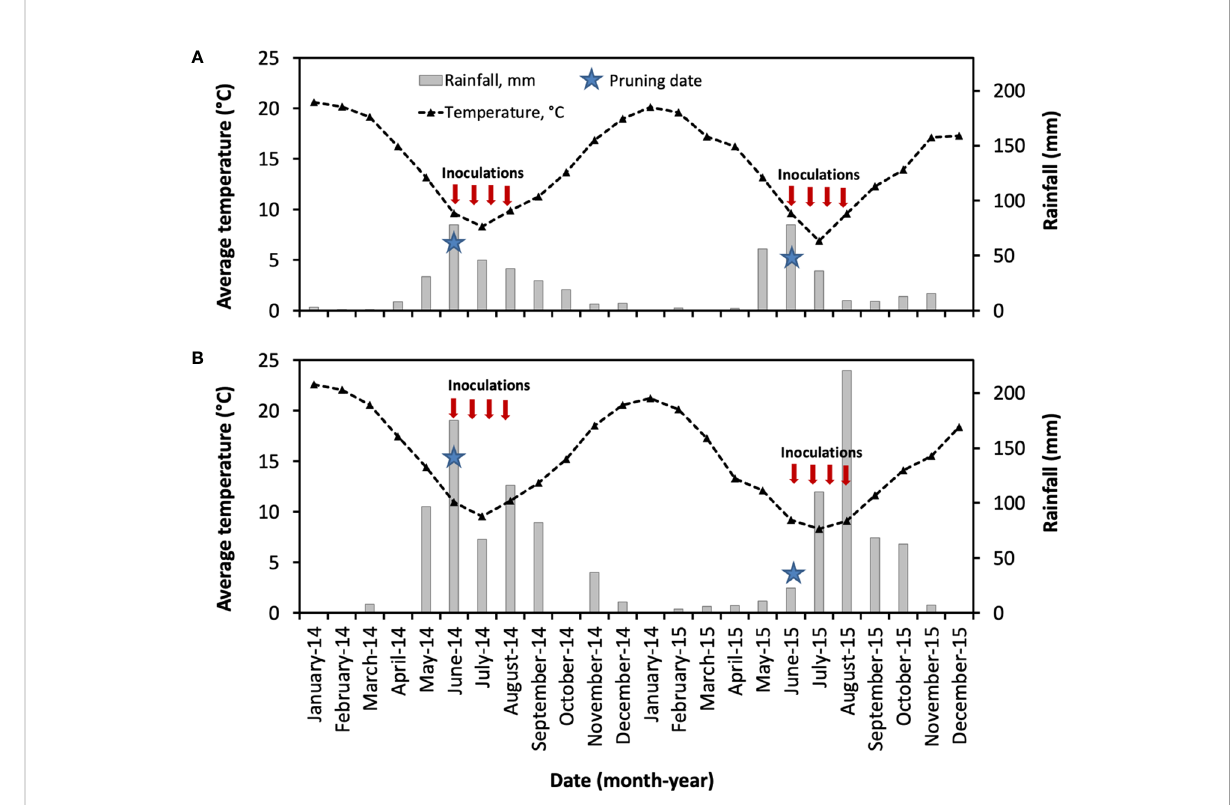
FIGURE 7 Weather conditions in the commercial vineyards cv. Cabernet Sauvignon showing the mean month of temperature (segmented line, °C) and month accumulated rainfall (gray bar, mm) located in Buin (A) and Nancagua (B) in Central Chile, during the seasons 2014 and 2015. Star indicates the date of